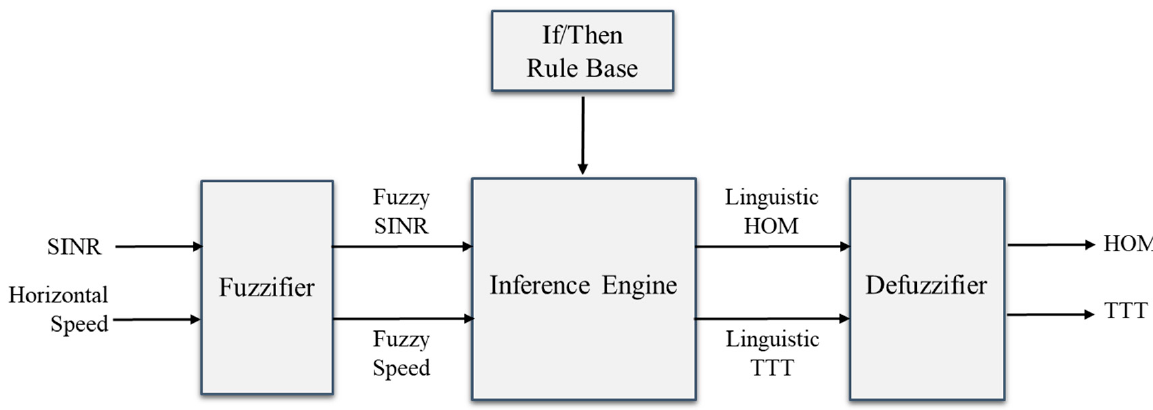
Figure 5. FL controller of FLDHDT.